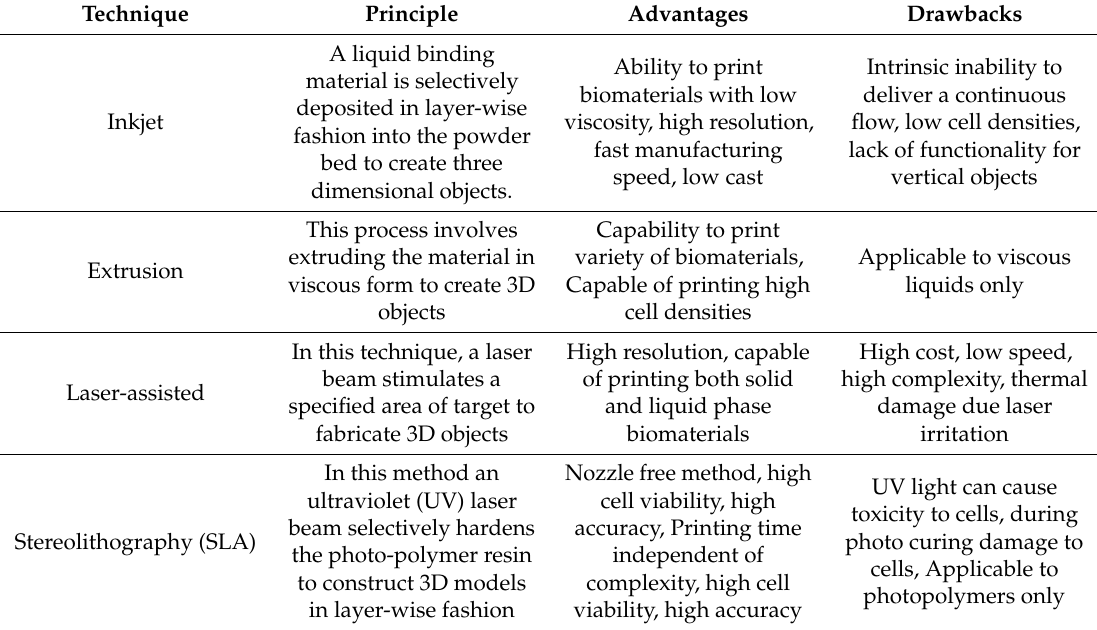
Figure 7. Schematic diagrams of three different techniques of photopolymerization [18]. Table 1. Summary of major 3D-bioprinting techniques for bone tissue engineering.